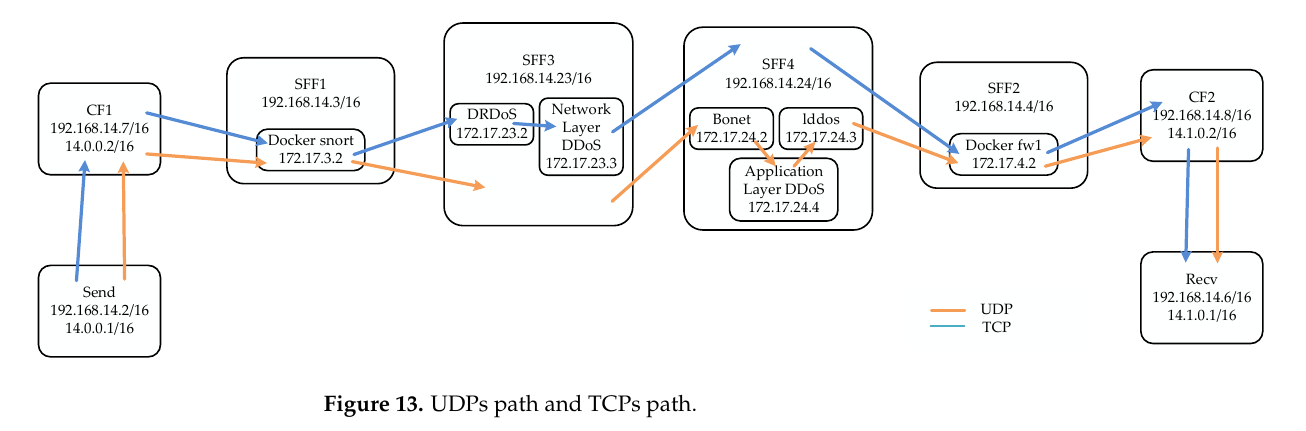
Figure 13. UDPs path and TCPs path.